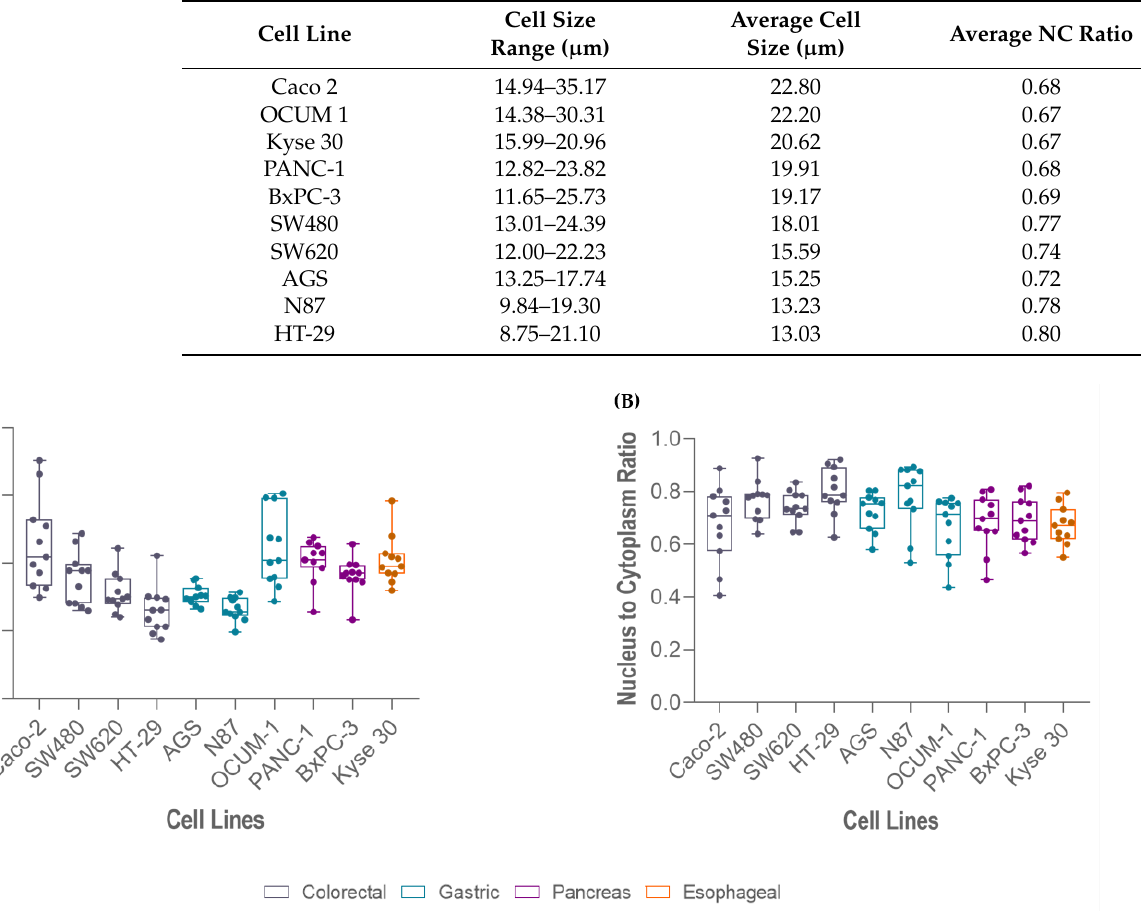
Figure 4. Measurements of different gastrointestinal cancer cell lines (Caco-2, OCUM 1, Kyse 30, PANC-1, BxPC-3, SW480, SW620, AGS, N87, HT-29): ( A ) cell size, and ( B ) nucleus-to-cytoplasm (NC) ratio.